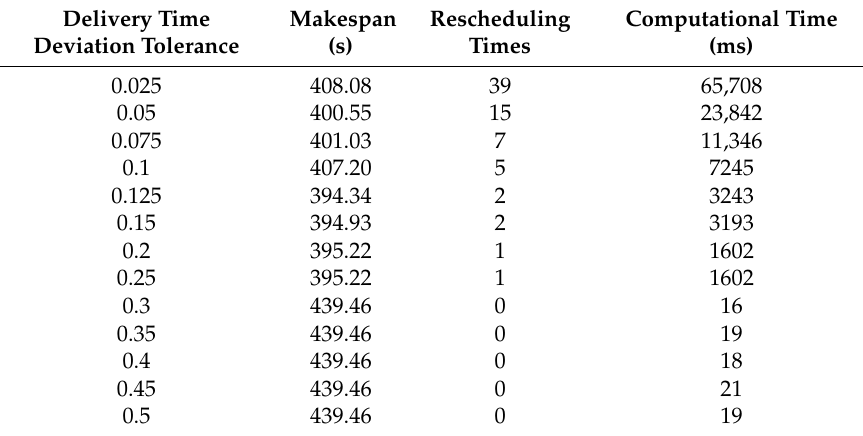
Table 3. Results of delivery time deviation tolerance experiments.